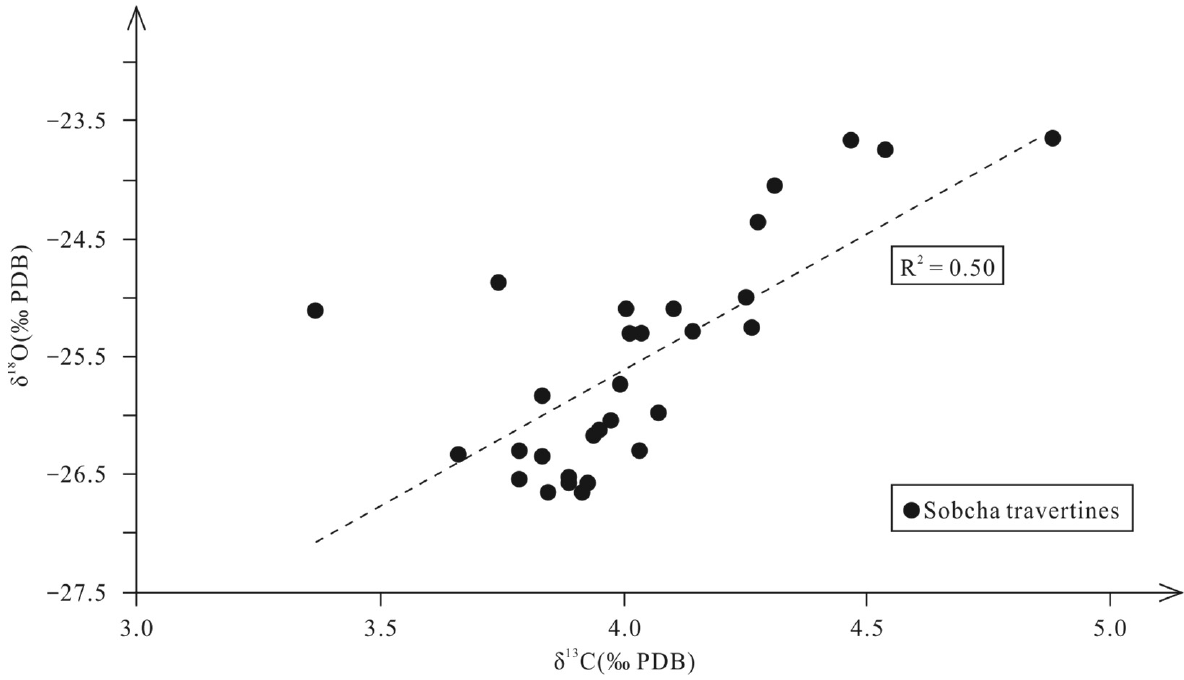
Figure 4. Bivariant graph of δ 18 O and δ 13 C of travertines from Sobcha.